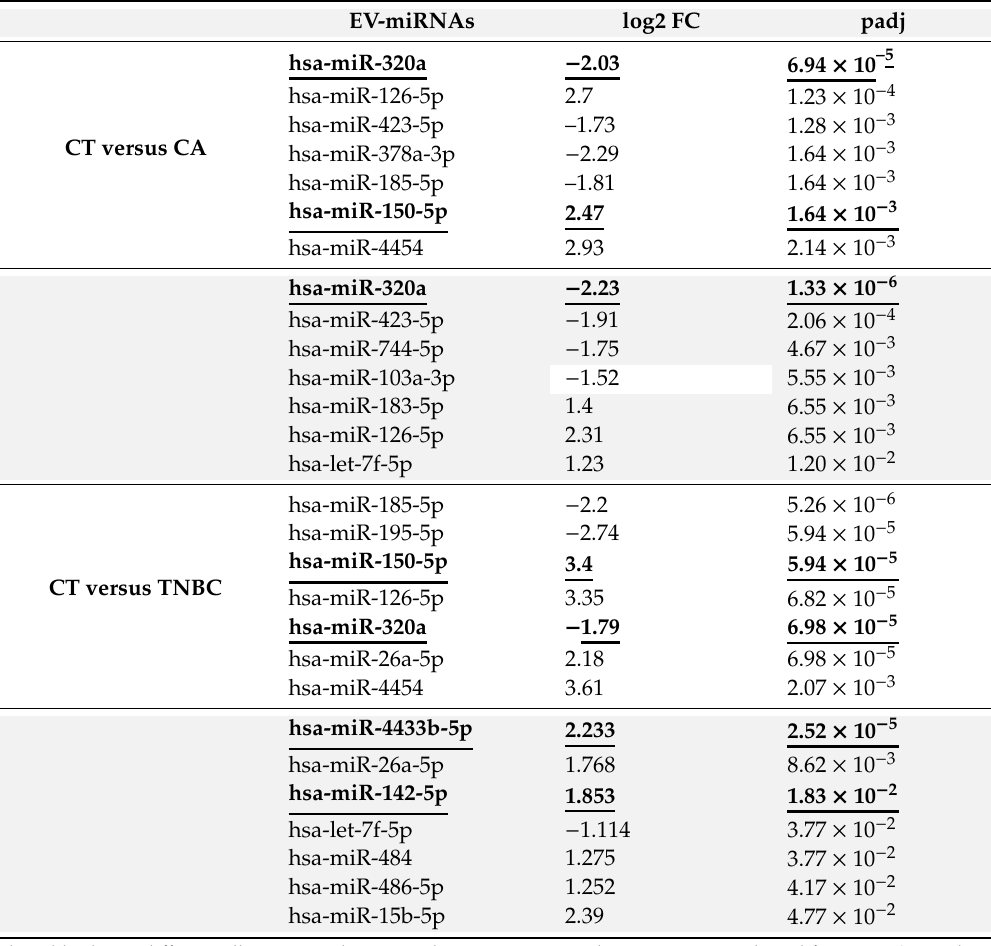
Table 2. Top seven EV-miRNAs di ff erentially expressed in RNA-seq analysis (screening phase) organized by adjusted p